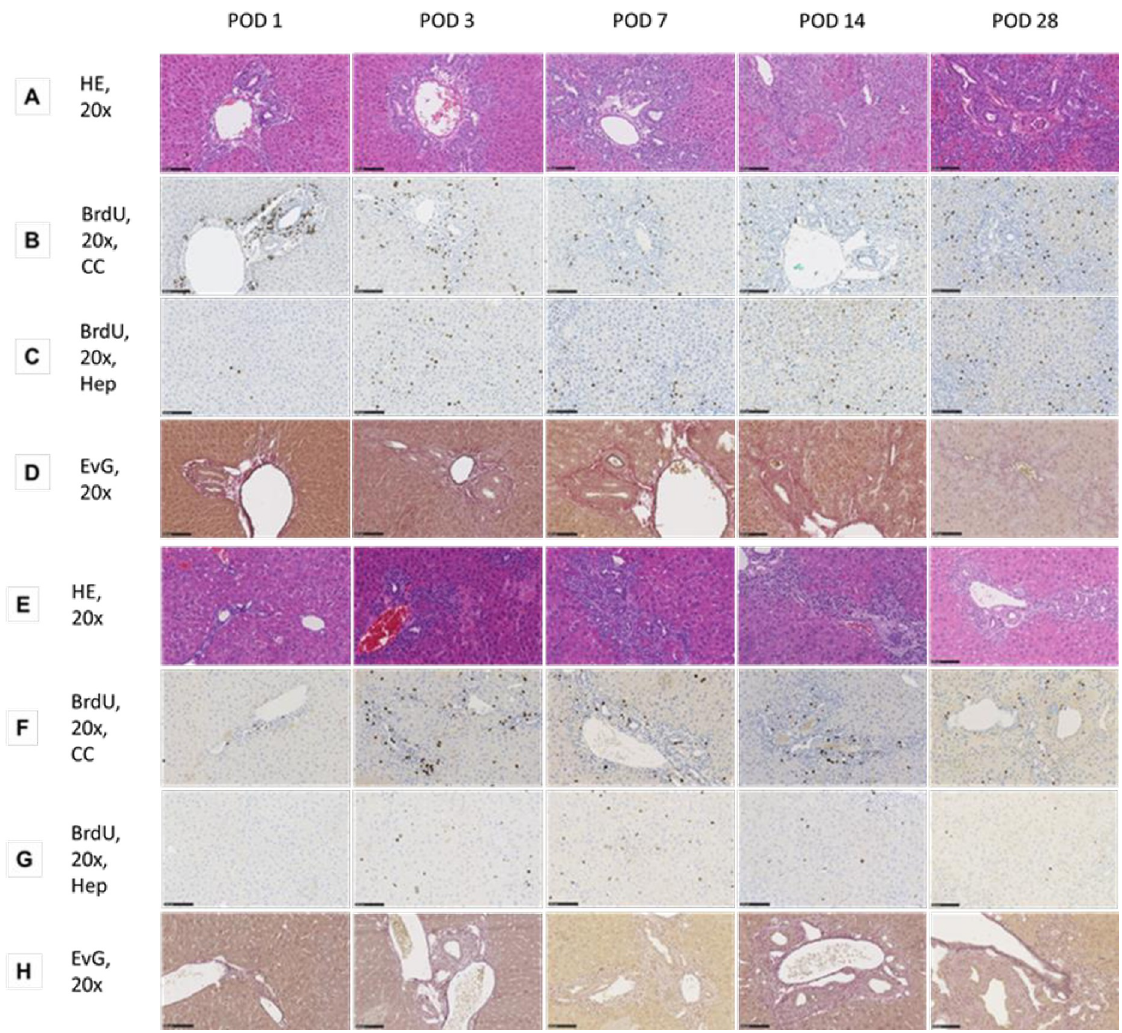
Fig 3. A-H: Histological and immunohistochemical images (HE, BrdU, EVG) after tBDT in rats (A-D) and mice